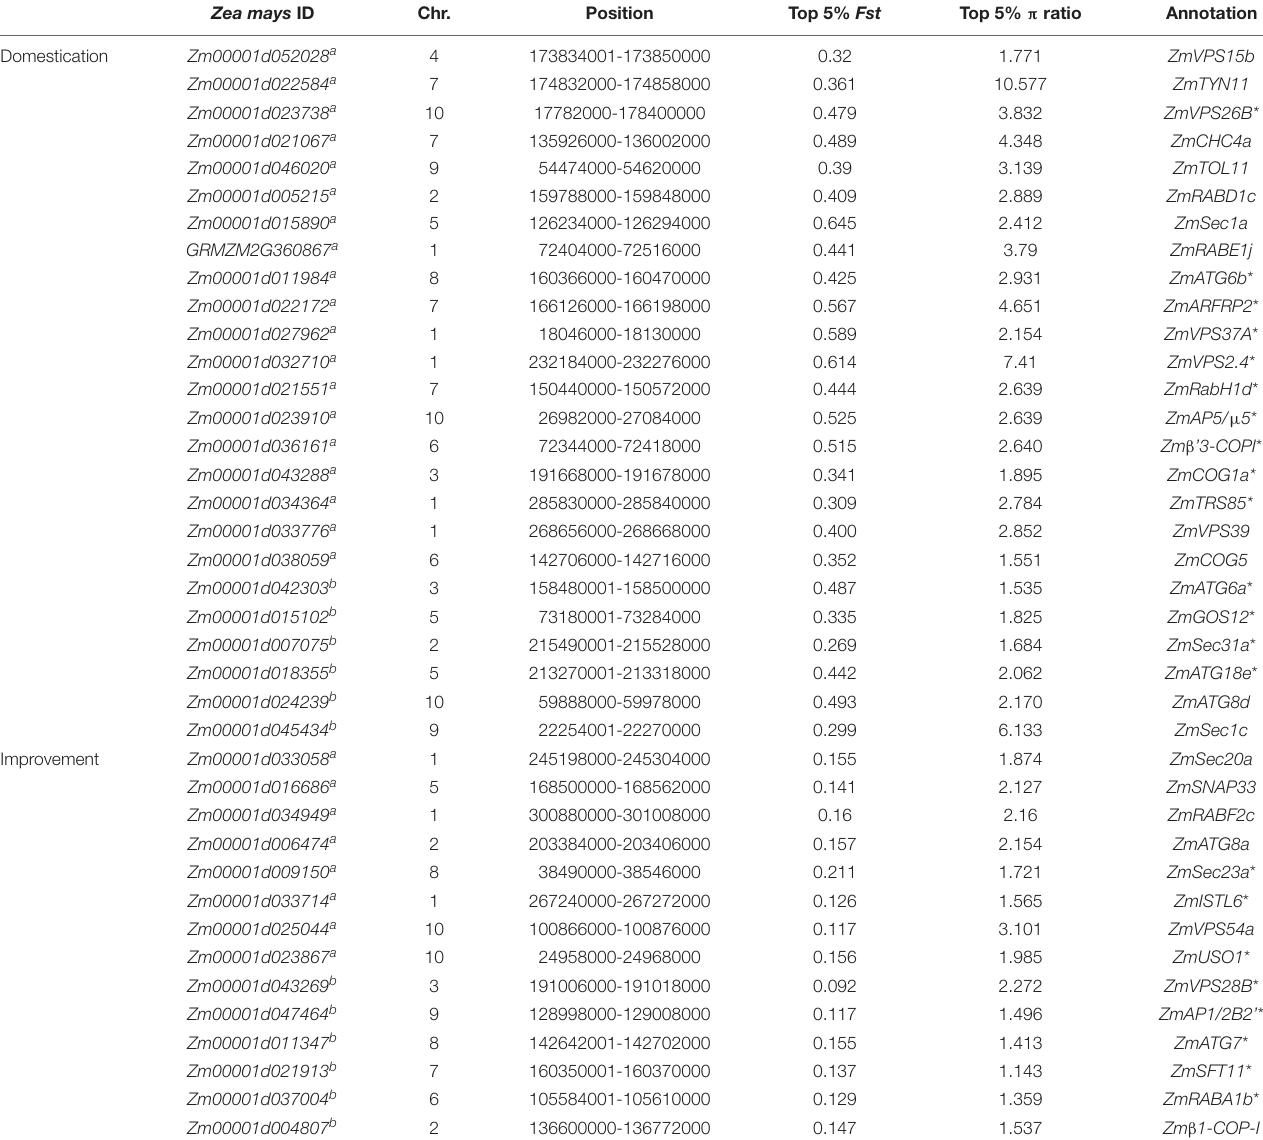
TABLE 1 | Membrane-trafficking genes selected during maize domestication and improvement. Zea mays ID Chr. Position Top 5% Fst Top 5% π